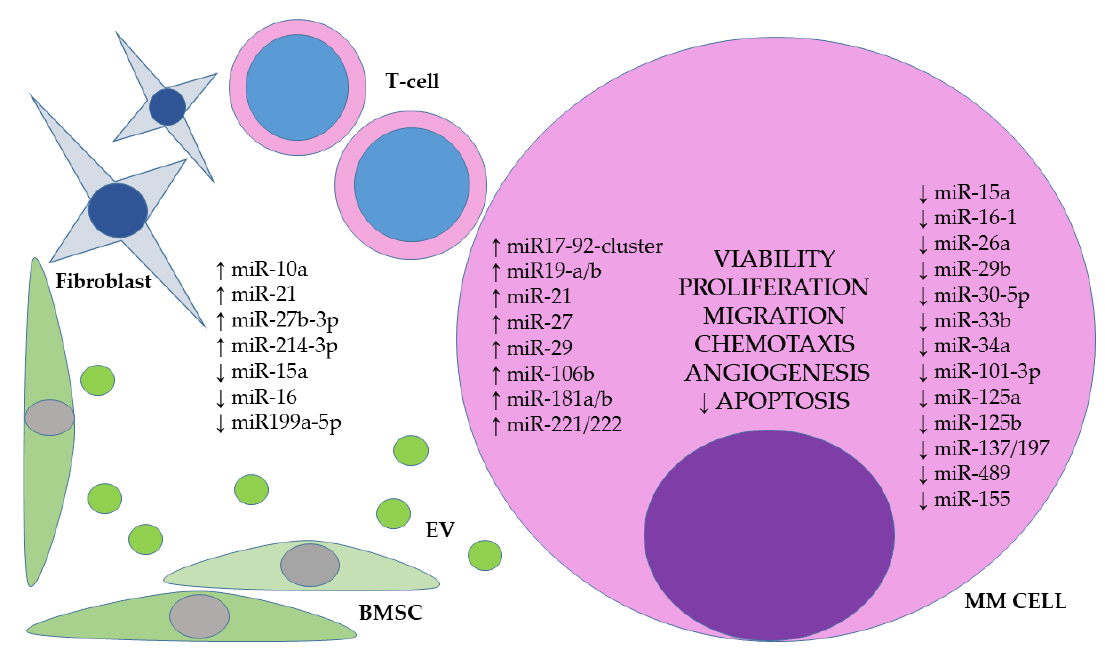
Figure 1. miRNA expression in MM pathogenesis. BMSC–bone marrow stem cells, EV–extracellular vesicle, MM–multiple myeloma, ↑ - increased expression, ↓ - decreased expression.